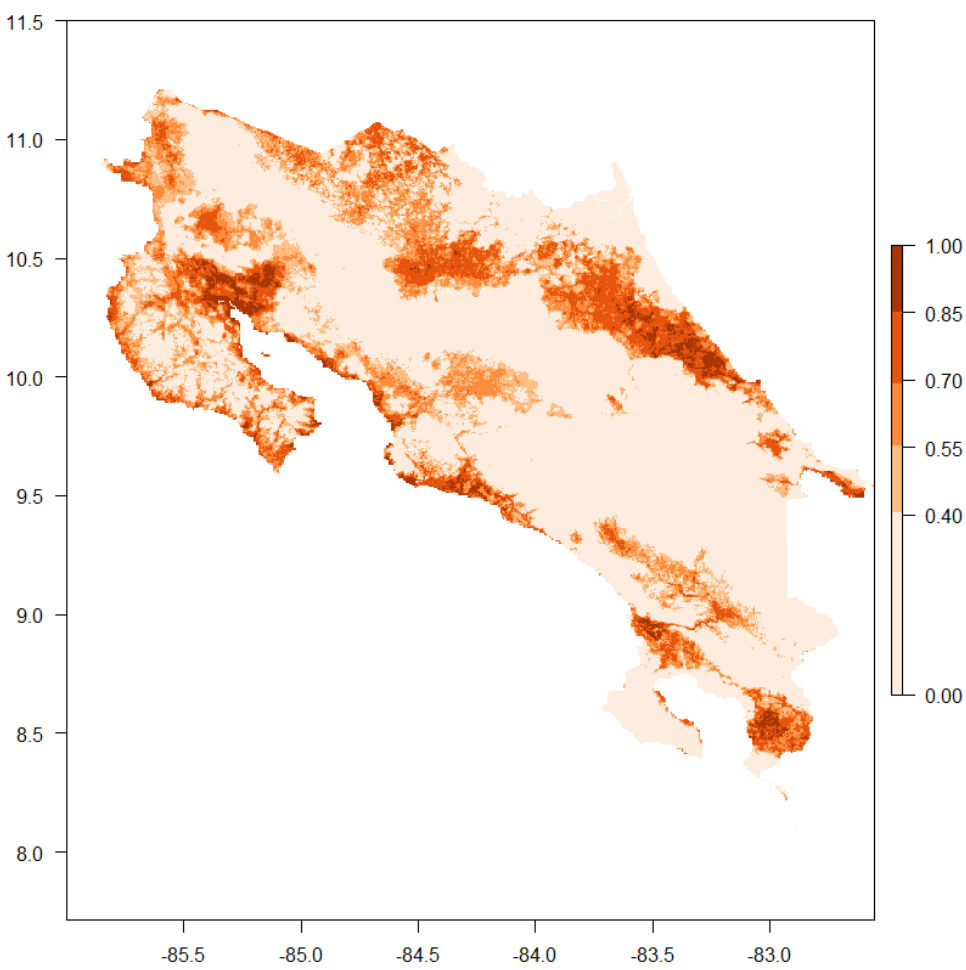
Figure 6. Ensemble distribution model for Anopheles albimanus in Costa Rica. Color indicates habitat suitability measured as a probability from 0 to 1 as presented in the legend; the Y axis is the latitude, and the X axis is the longitude. The AUC (mean ± SD) for this ensemble model was 0.983 ± 0.001 and the TSS (mean ± SD) was 0.833 ± 0.007, outperforming all individual models presented in Table 2. These raster results are available at https://osf.io/acjyg/.